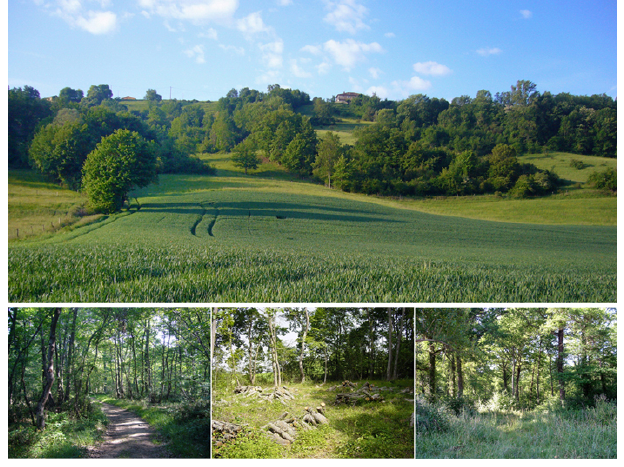
Fig. 6 . Farmers’ forests in French Gascogne: a fragmented forest-type in agricultural lands managed for firewood production, game hunting and mushroom collection, with high levels of